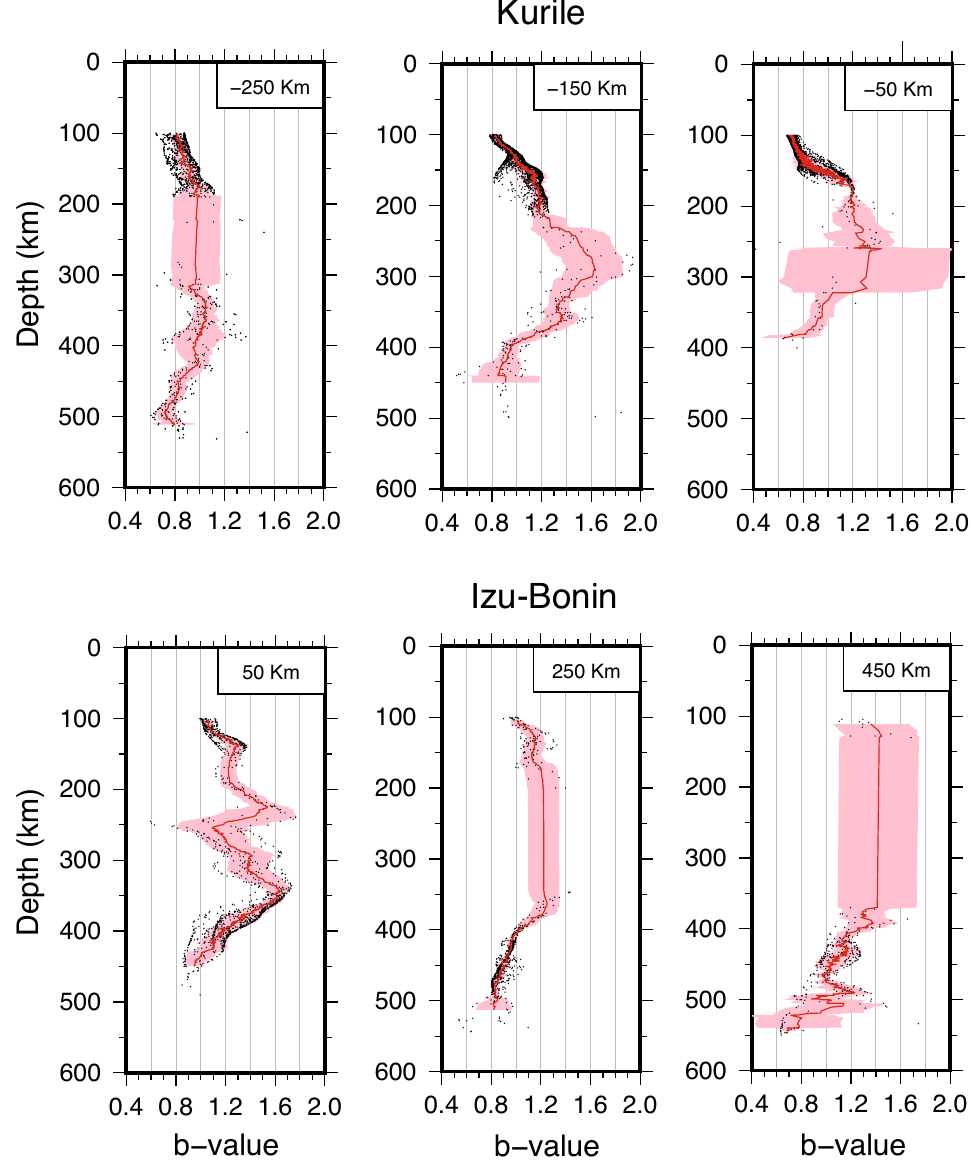
Figure 4. Depth distributions of the estimated b -values along selected profiles. Each depth profile includes values along 100 km-thick slices, centered at the distance indicated on top, along the relevant profile. The red lines represent the 30 pts. moving average, except for the 450 km I–B profile, for which a 10 pts. average is applied due to the lower number of points available, while the red shaded bands represent the standard deviation of the moving average. See Figs. S3 and S4 for all the